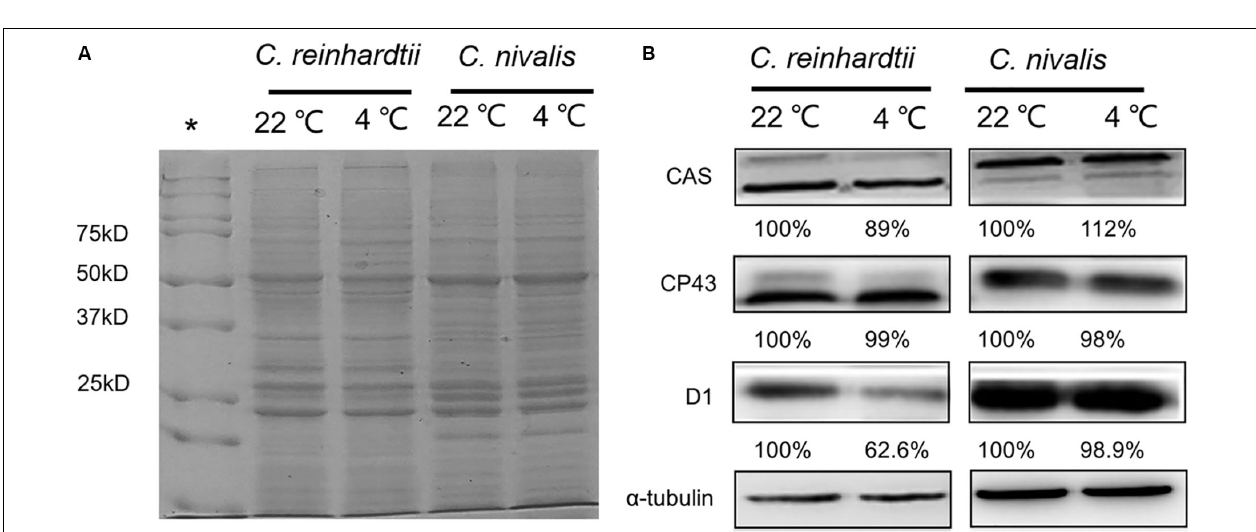
FIGURE 3 | Electron transfer rate of C . nivalis and C. reinhardtii at 22 and 4 ◦ C. (A) PSII electron transfer. (B) PSI electron transfer. (C) Cyclic electron transfer. (D) Expression of CAS using real-time fluorescence quantitative PCR. The significance of the differences between 22 and 4 ◦ C in the same strain were tested using a one-way ANOVA. * p < 0.05, ** p < 0.01.